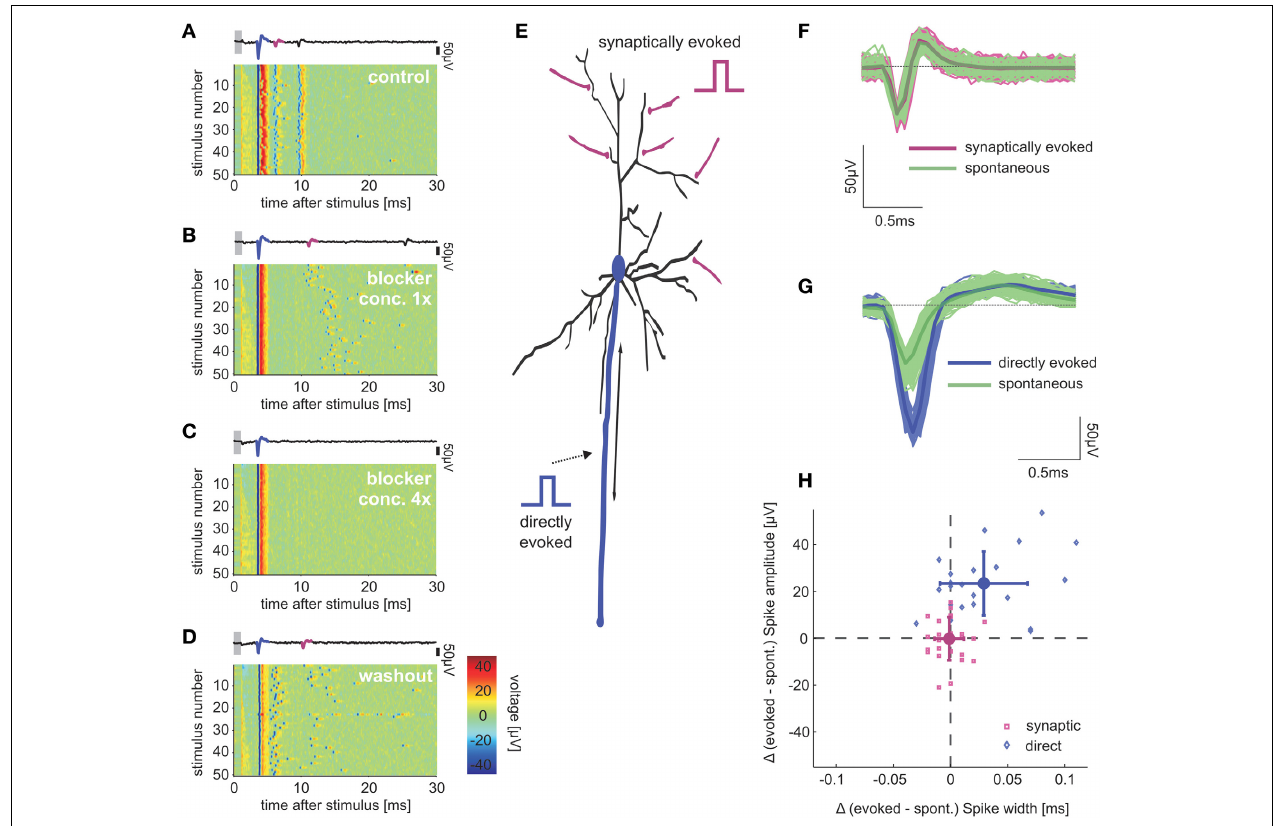
FIGURE 1 | Direct and synaptically mediated response spikes. Pseudo-color plots (A–D) show voltage traces detected by an electrode that records both directly evoked and synaptically mediated spikes, in different concentrations of synaptic blockers: (A) Control solution with no blockers; (B) Added blockers (8 μ M APV, 4 μ M CNQX, 2 μ M BIC); (C) Four-fold concentrations compared to (B) ; and (D) Back to control solution after washing out the blockers. Single voltage traces above each panel depict direct (blue) and synaptic (magenta) mediated spikes in the first trace of each condition. Focusing on the immediate synaptically evoked responses, we did not consider secondary spikes of the synaptically activated neuron. Gray bars mark blanking period. Color bar in (D) indicates voltage-color correspondence, identical in (A–D) . (E) Conceptual scheme of the two local responses to direct (blue) and